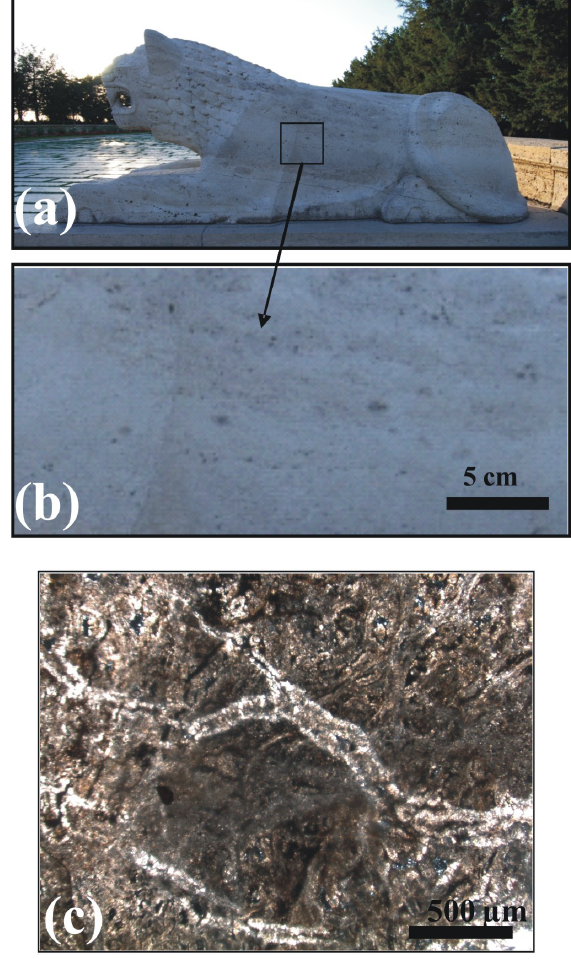
Fig. 3. (a) A lion statue, (b) close view to surface of lion and (c) microphotograph of white-colored